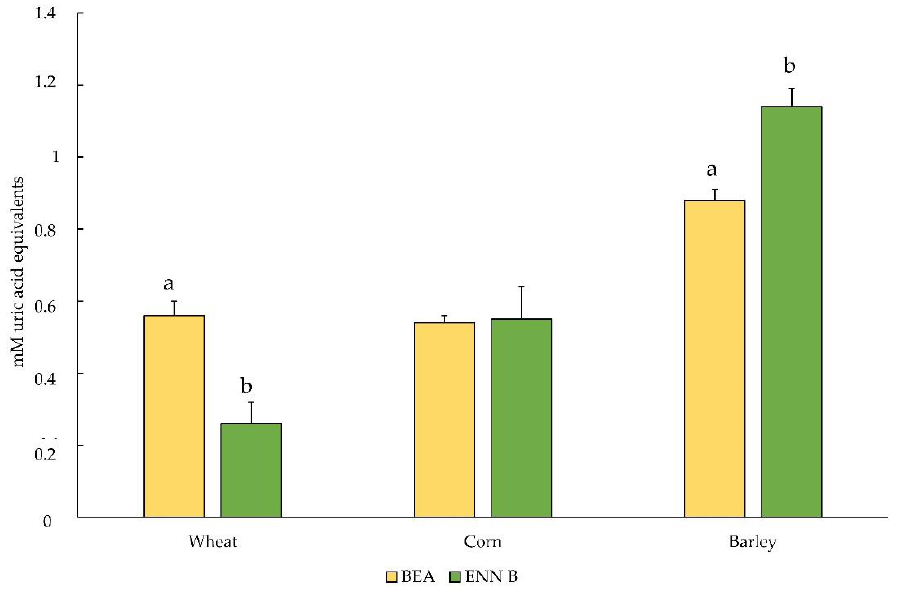
Figure 2. Total antioxidant capacity values (in mM uric acid equivalents) of cereal flours contaminated with BEA and ENN B mycotoxins: BEA, beauvericin; ENN B, enniatin B. Different letters above the bars indicate significant differences at p ˂ 0.05.